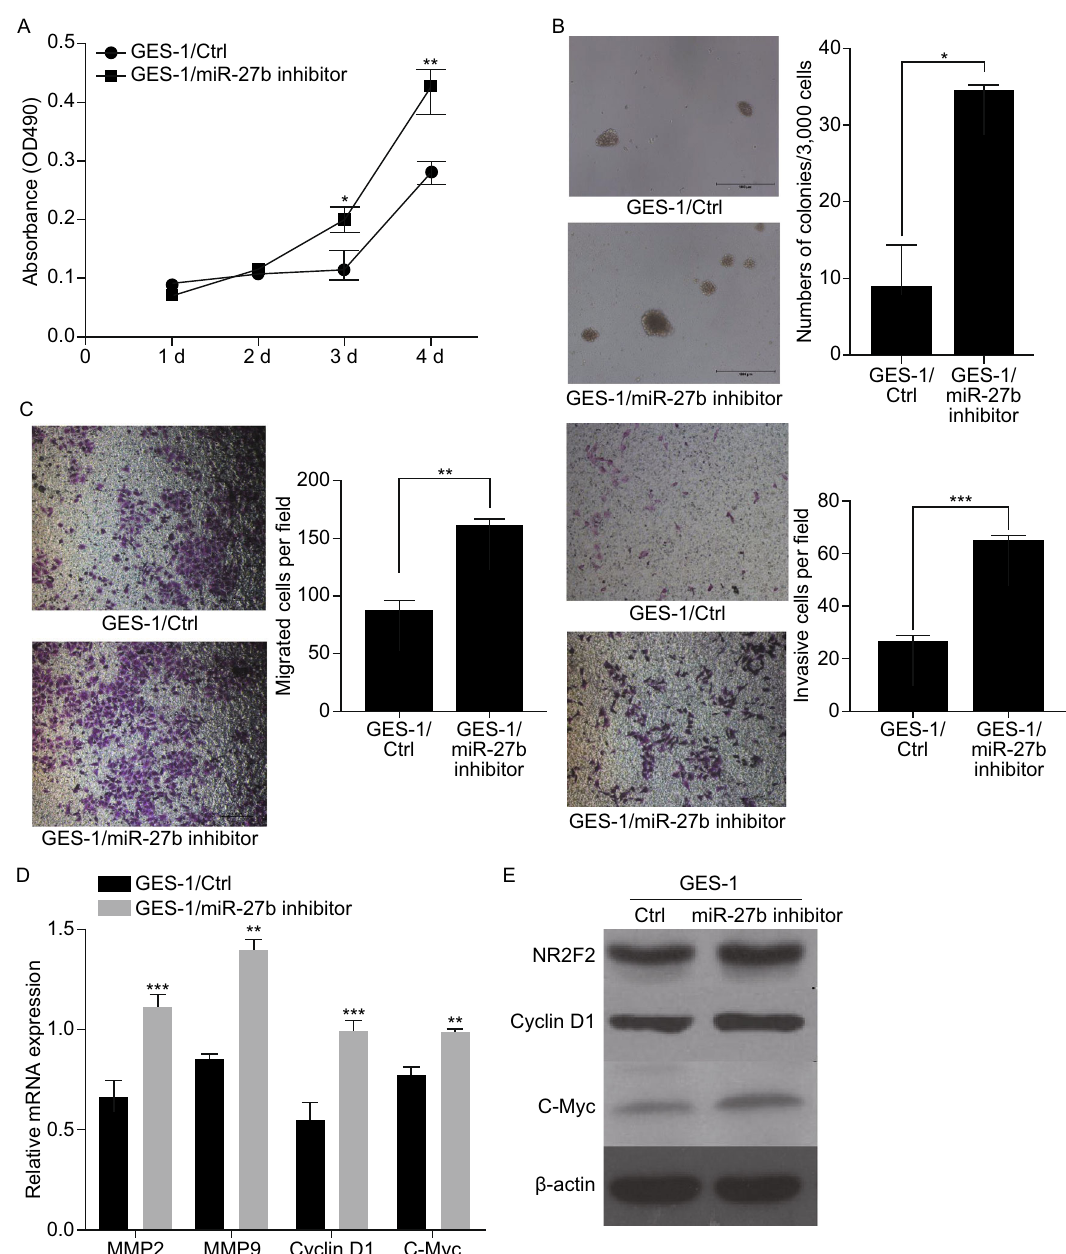
Figure 4. miR-27b inhibitor promotes gastric cancer cell growth, migration, and invasion in vitro . (A) The effect on cell proliferation of miR-27b inhibitor in GES-1 cells was determined by the MTT assay. (B) Representative images show the colony formation of GES-1/miR-27b inhibitor and their control cells (left panel). Average colonies in each well for each group were counted from three independent experiments (right panel). (C) The effects of miR-27b inhibitor in GES-1 cells on cell migration and invasion were analyzed by Transwell migration and Matrigel-coated Transwell invasion analyses. (D) Q-RT analysis proliferation and metastasis genes. (E) Western blot analysis of proliferation and metastasis genes. * P < 0.05, ** P < 0.01, *** P